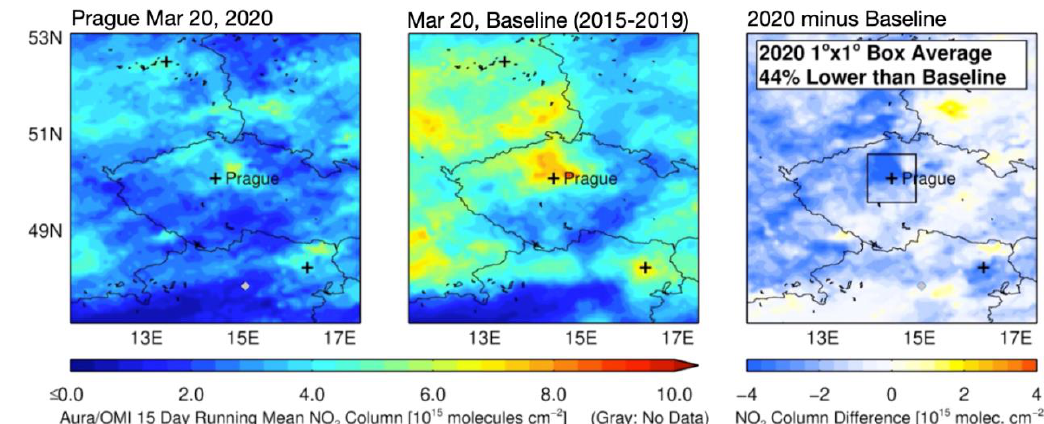
Figure 6. Nitrogen dioxide concentrations over Prague on 20 March of 2020 compared with 20 March from the baseline period (2015–2019). Source: NASA AURA [23].